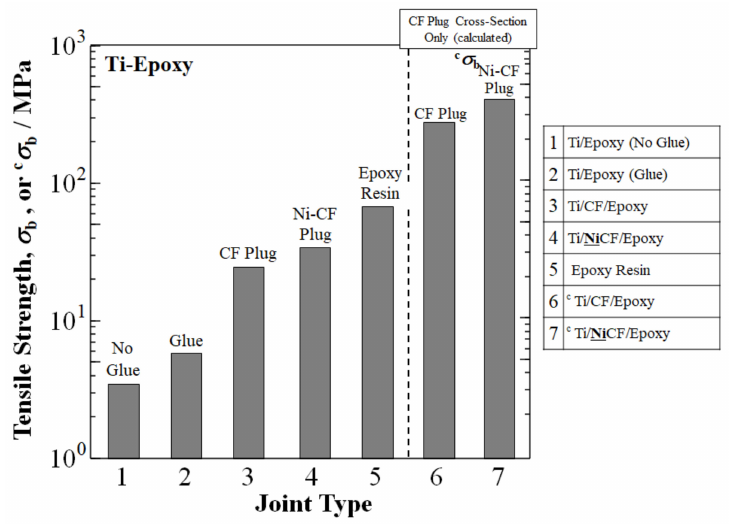
Figure 8. Advances in UTS of Ti/epoxy joints with CF plug. Data is from Hasegawa, Inui, Shi- raishi, Ishii, Kasai, Matsumura, and Nishi (2016) [45]; and Nishi, Uchida, Faudree, Kaneko, Kimura (2019) [46]. Reported data of UTS of epoxy resin from Shackelford (2000) is also shown